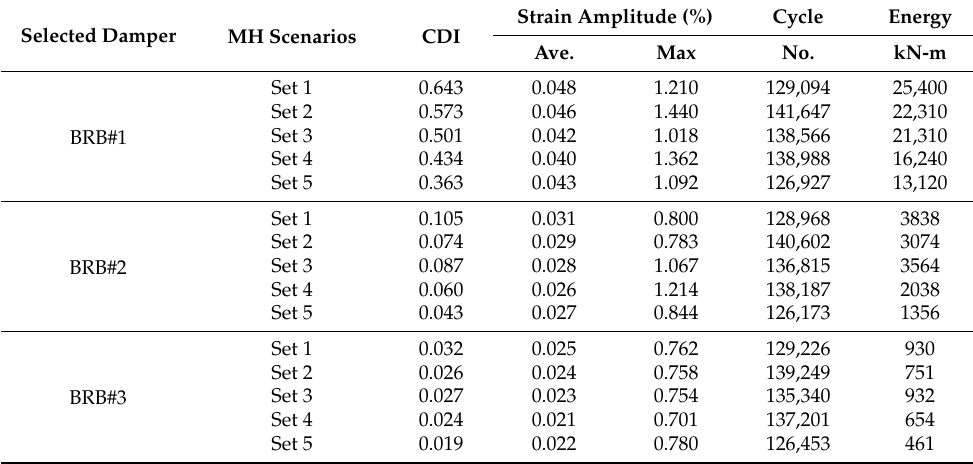
Table 7. Cycle counting, strain amplitude, and CDI of selected BRBs under multi-hazard timelines. Selected